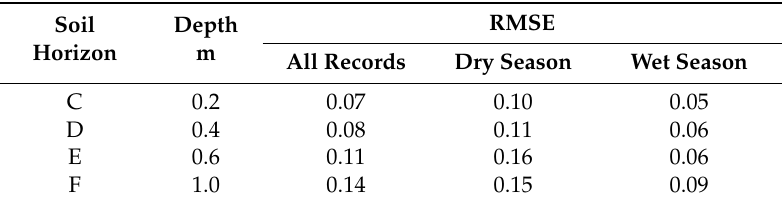
Table 6. Rootmeansquare error (RMSE) indices of the modeled trends of the degree of saturation for the investigated soil